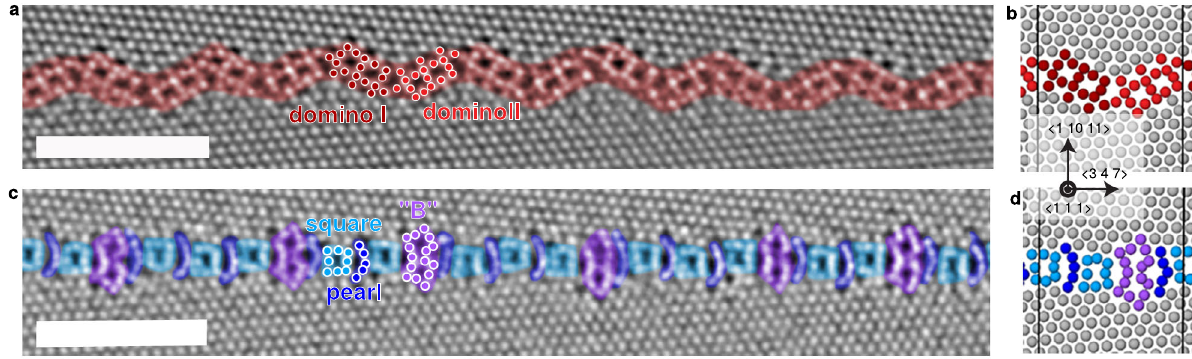
Fig. 3 The two GB phases in a nearly symmetric Σ 37c 〈 111 〉 {1 10 11} GB in Cu as observed by HAADF-STEM. The sub-atomic structures of the domino phase ( a ) and the pearl phase ( c ) are indicated by the colouring. The scale bars represent 2 nm. b , d Corresponding structures obtained from atomistic simulations with the EAM potential by Mishin et al. 34 . The motifs are the same as in the experiment. The black lines indicate the unit cell of the GB